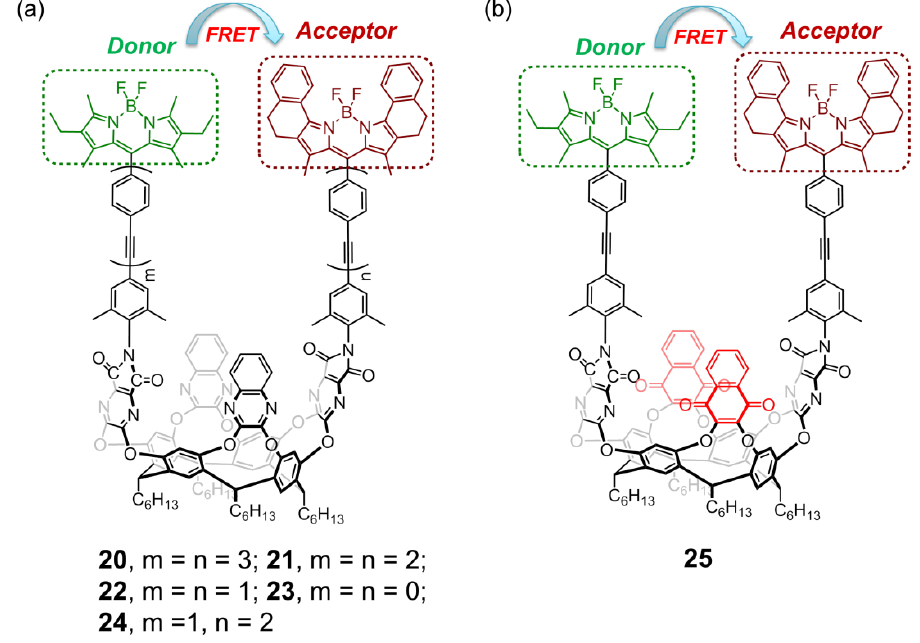
Figure 15. Chemical structure of ( a ) BODIPY-functionalized oligo(phenylene ethynylene)s 18a–c and ( b ) BODIPY-decorated resorcin[4]arenes 19 and ( c ) 20 together with its models the contracted (vase) and expanded (kite) states. Reproduced with permission from Reference [95]. Copyright 2005 John Wiley and Sons.